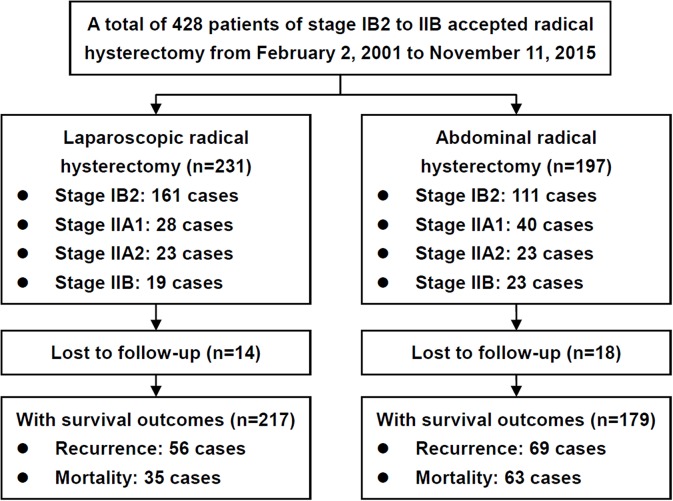
Flow diagram of the study.